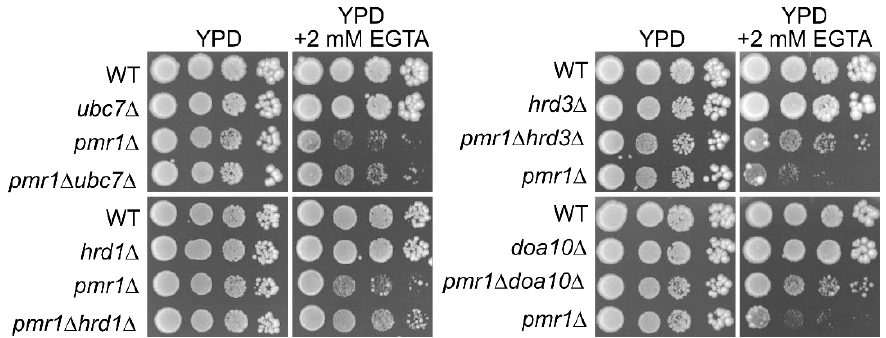
Figure 3. Deletion of major ERAD components suppresses the EGTA (Ethylene glycol-bis(β-ami- noethyl ether)-N,N,N′,N′-tetra-acetic acid) sensitivity of pmr1 ∆ cells. Serial 10-fold dilutions of yeast cultures were spotted onto yeast extract-peptone-dextrose medium (YPD) or YPD containing 2 mM EGTA. Plates were incubated for 3–7 days. The strains used here were BY4741 (wild-type) and its mutant derivatives.